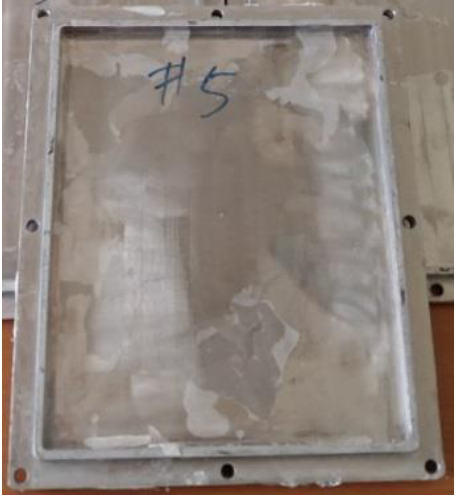
Figure 4. Mold for CIPP sample production.